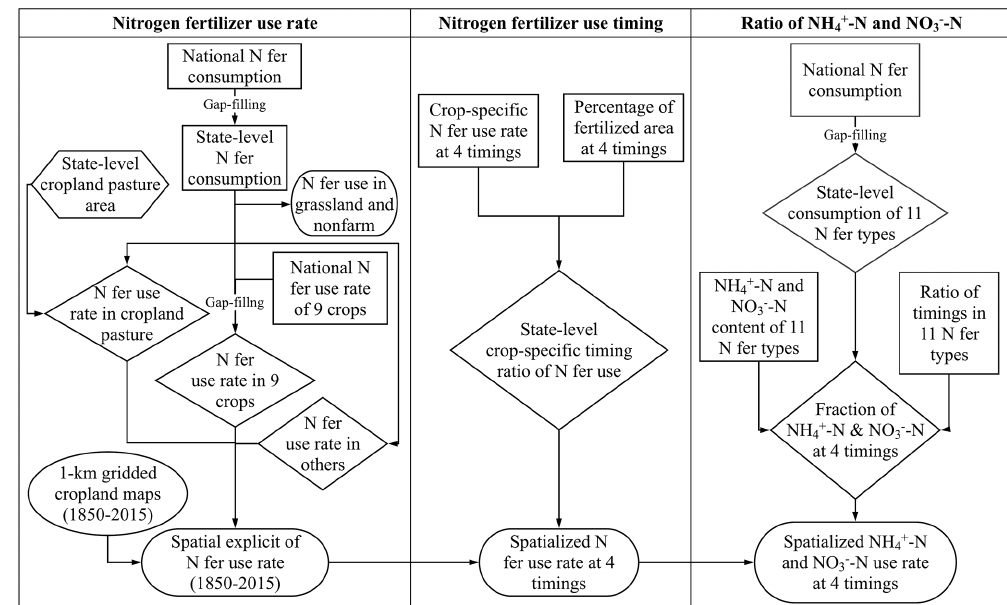
Figure 1. Workflow diagram for developing spatially explicit time series of N fertilizer use data (including rate, application timing, and NH + -N and NO − -N use rate) in the contiguous US during the period from 1850 to 2015. “N fer” is used to refer to N fertilizer and “4 4 3 timings” refers to fertilizer application during the four application periods discussed in the